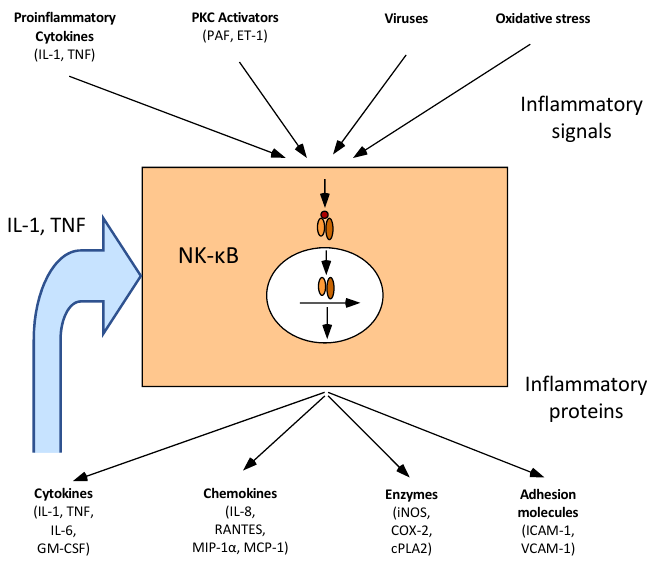
Figure 3. NF-κB central role in inflammation. Several pro-inflammatory signals such as cytokines, protein kinase C (PKC) activators, infectious agents or oxidative stress activates NF-κB. In response to these signals, NF-κB controls the expression of many mediators of the inflammatory reaction: